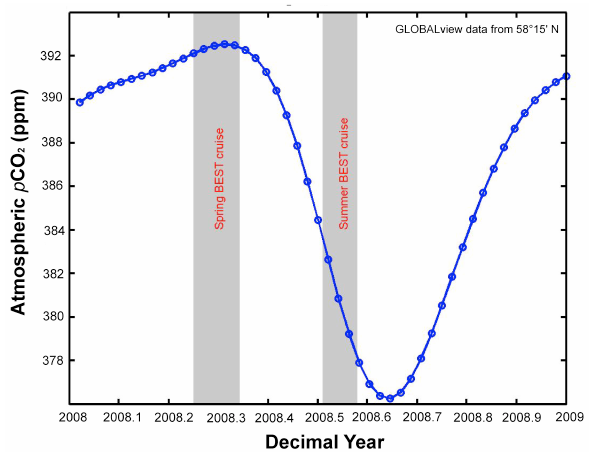
Figure 2 . Atmospheric CO 2 values (ppm) for the Bering Sea from GLOBALVIEW for 2008 (http://www.esrl.noaa.gov/gmd/ccgg/globalview/). The shaded areas represent the periods of time that the cruises were taking place. Atmospheric CO 2 values were then interpolated to the time each CTD hydrocast was conducted.